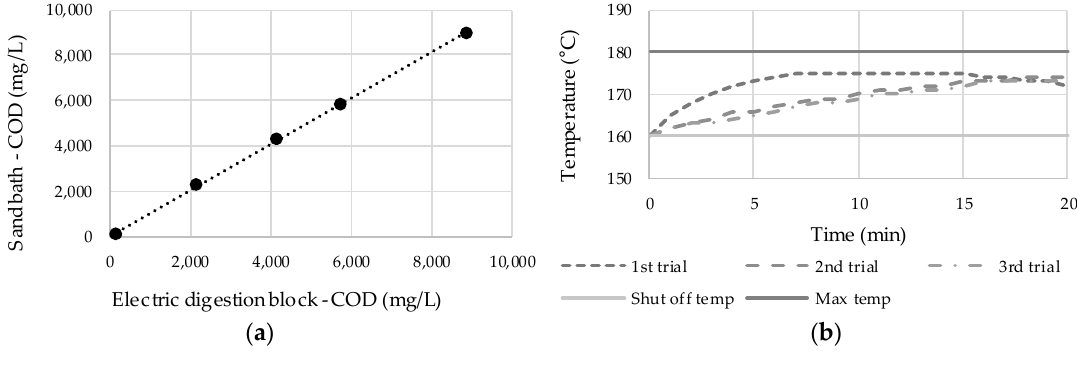
Figure 3. Modification of the Chemical Oxygen Demand (COD) method ( a ) comparison between electric digestion block and sand bath; ( b ) temperature curves for the sand bath digestion system.